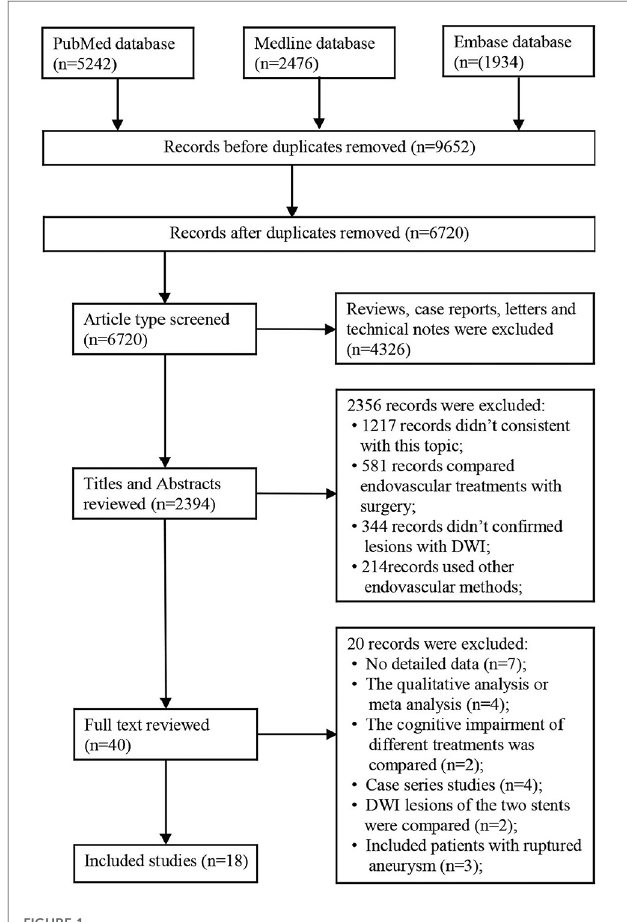
FIGURE 1 Flowchart of study